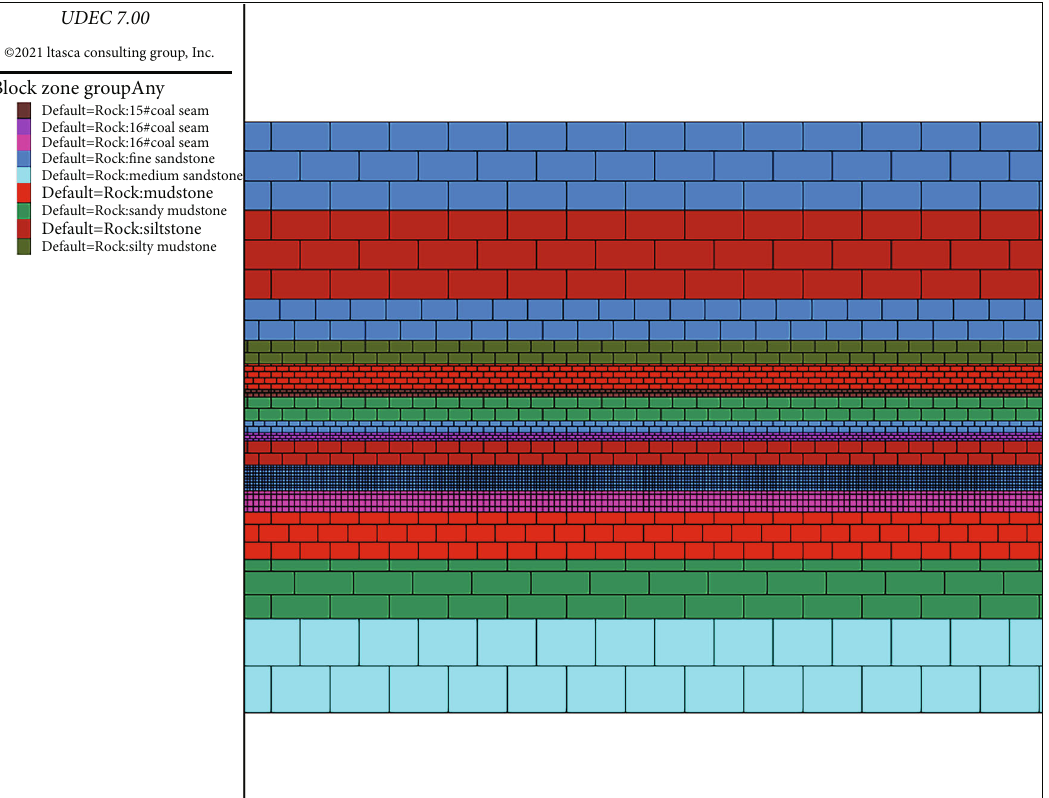
Figure 16: Numerical